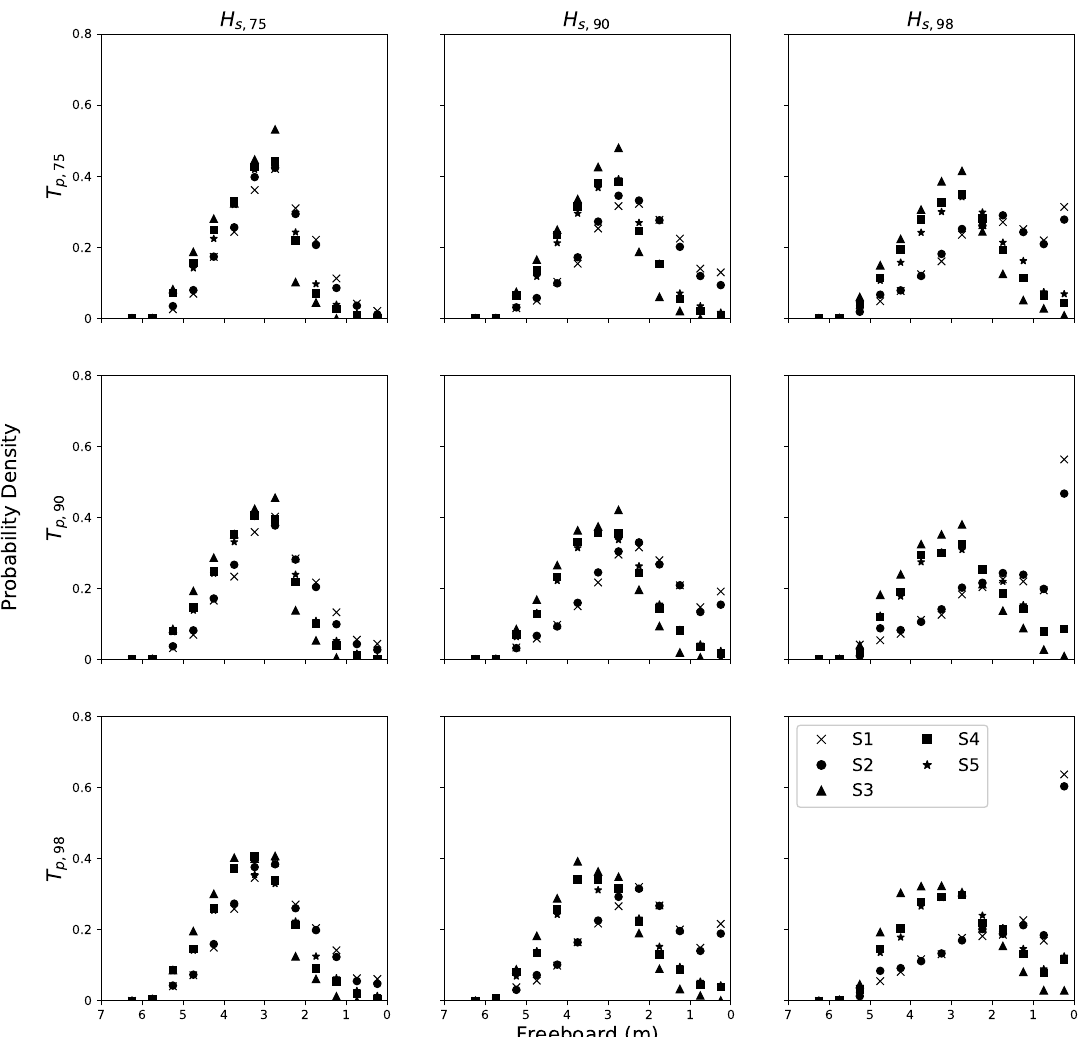
Figure 7. Distribution of modeled freeboard values under each H s - T p percentile combination and HAT for S1–S5. The distribution consists of freeboard values calculated when the water level exceeds the barrier toe ( ≥ 1.92